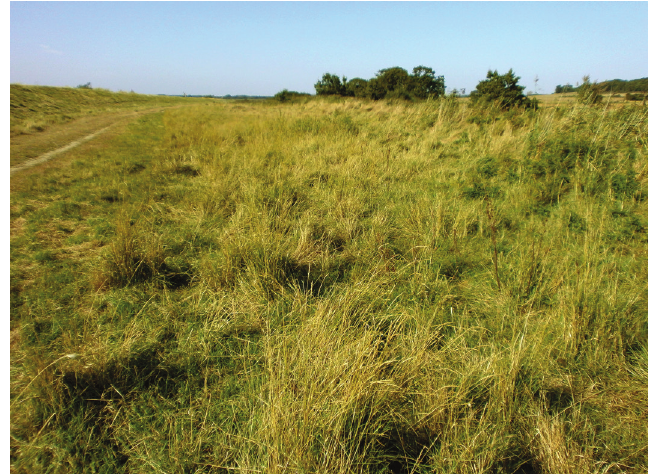
Fig. 9. Undisturbed grassland on a sea wall folding; credit T. Gardiner.